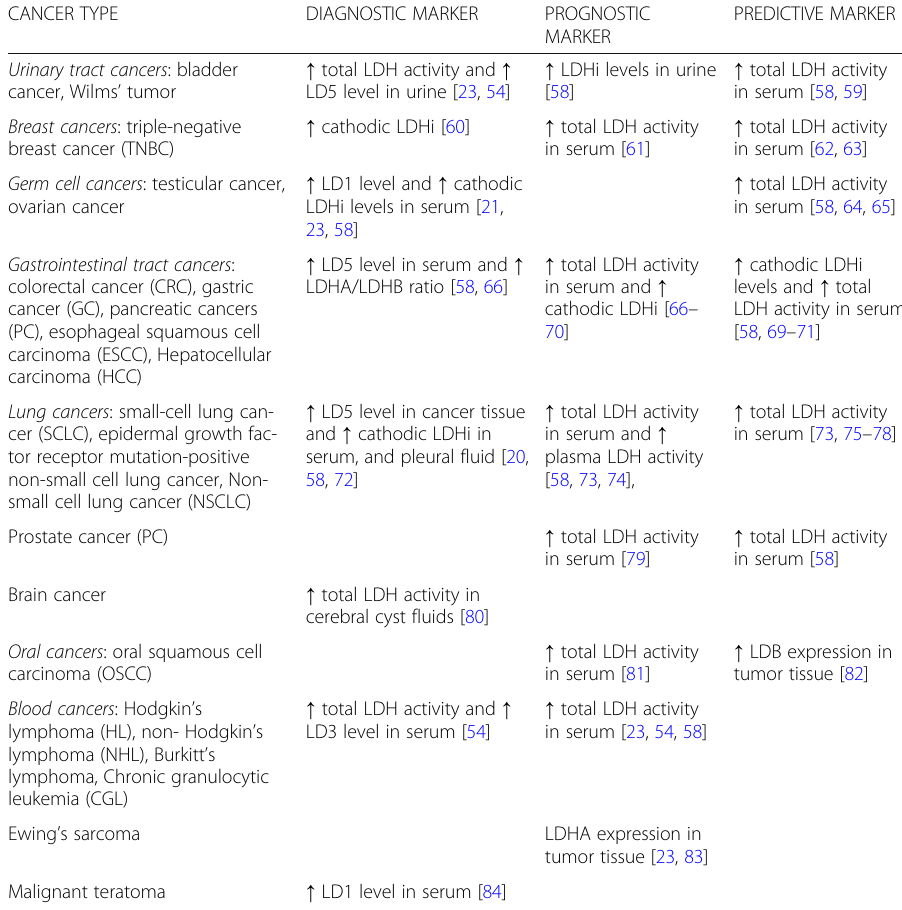
Table 1 The summary of some of published studies presenting data on LDH as a potential diagnostic, prognostic and predictive marker for cancers CANCER TYPE DIAGNOSTIC MARKER PROGNOSTIC